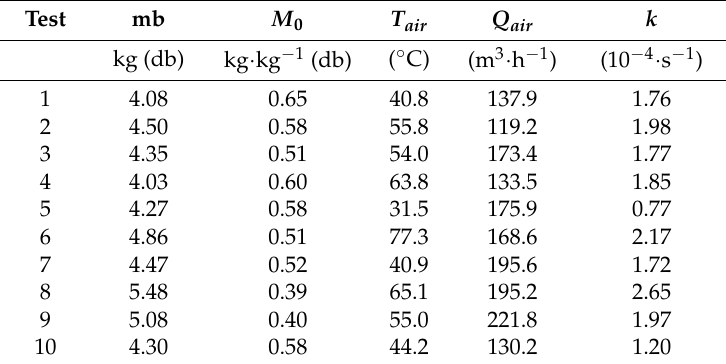
Table 3. Kinetic parameters of drying.